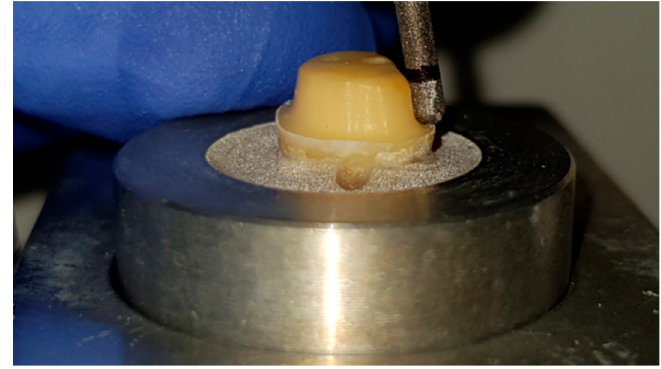
Figure 3. Tooth preparation in parallelometer.